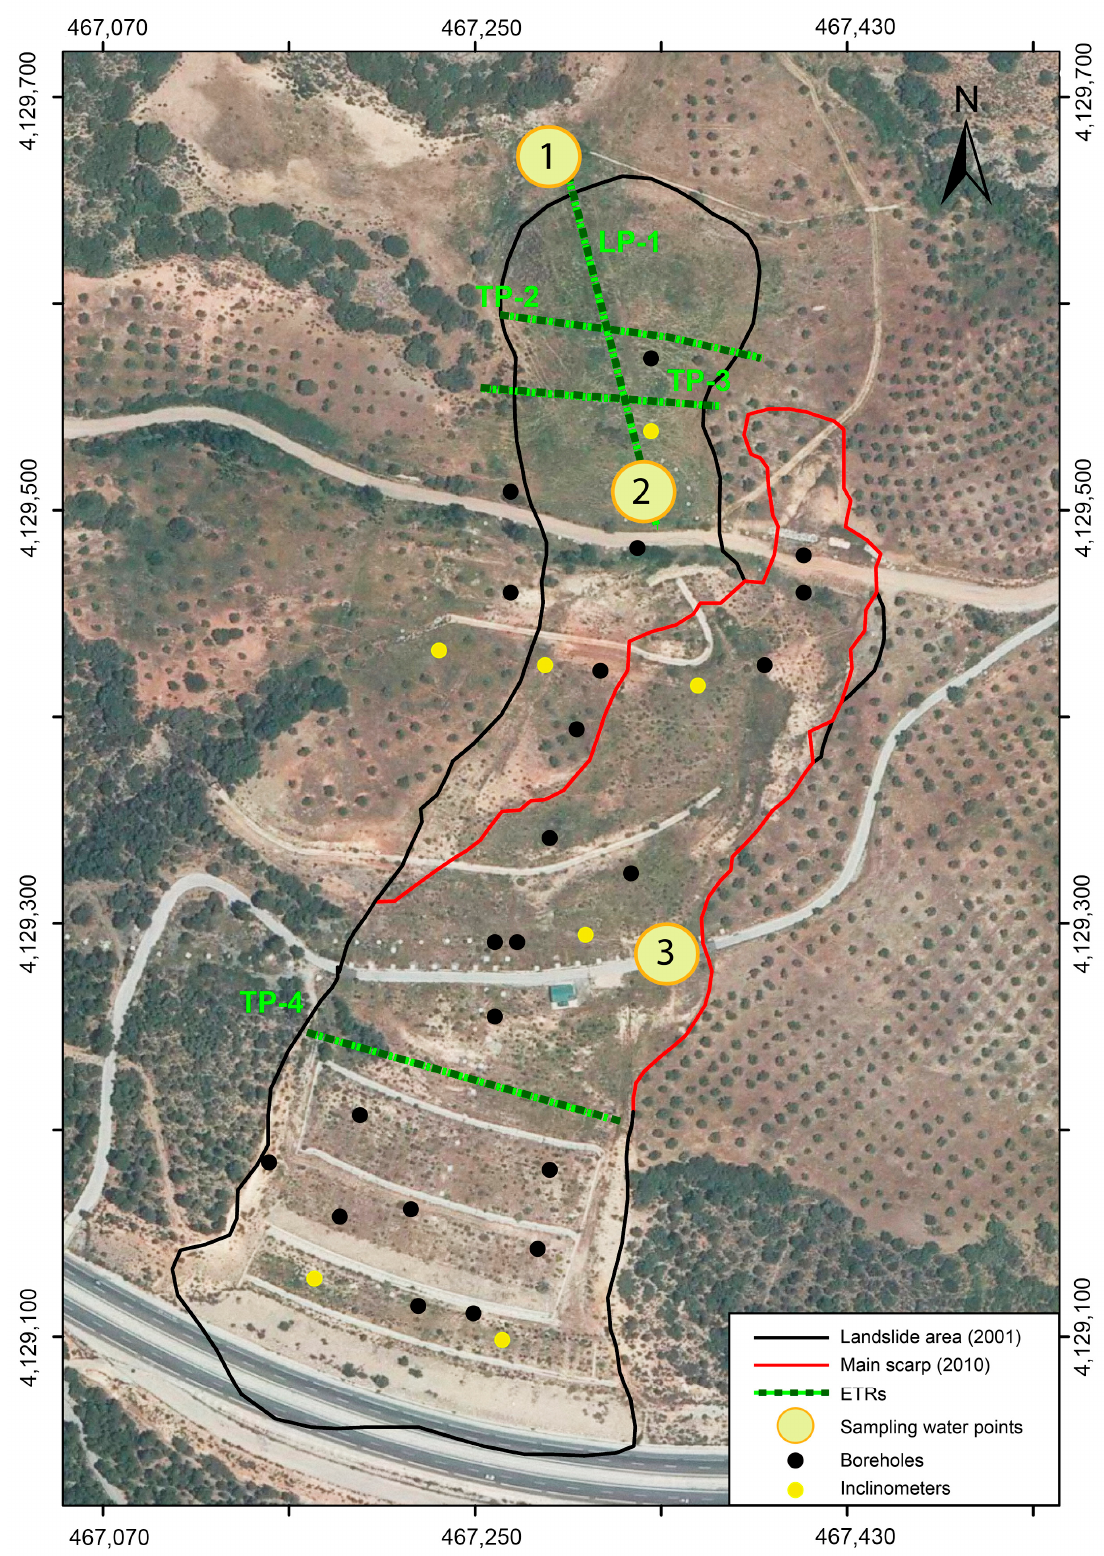
Figure 3. Aerial view of the Diezma landslide. The image shows the tracks of the electrical resistivity tomographies and the location of the three water sampling points. The first point corresponds to a natural upwelling (spring water). The second and the third points were taken in depth, in two of the drainage wells. The boreholes and inclinometers carried out in the landslide are also showed.